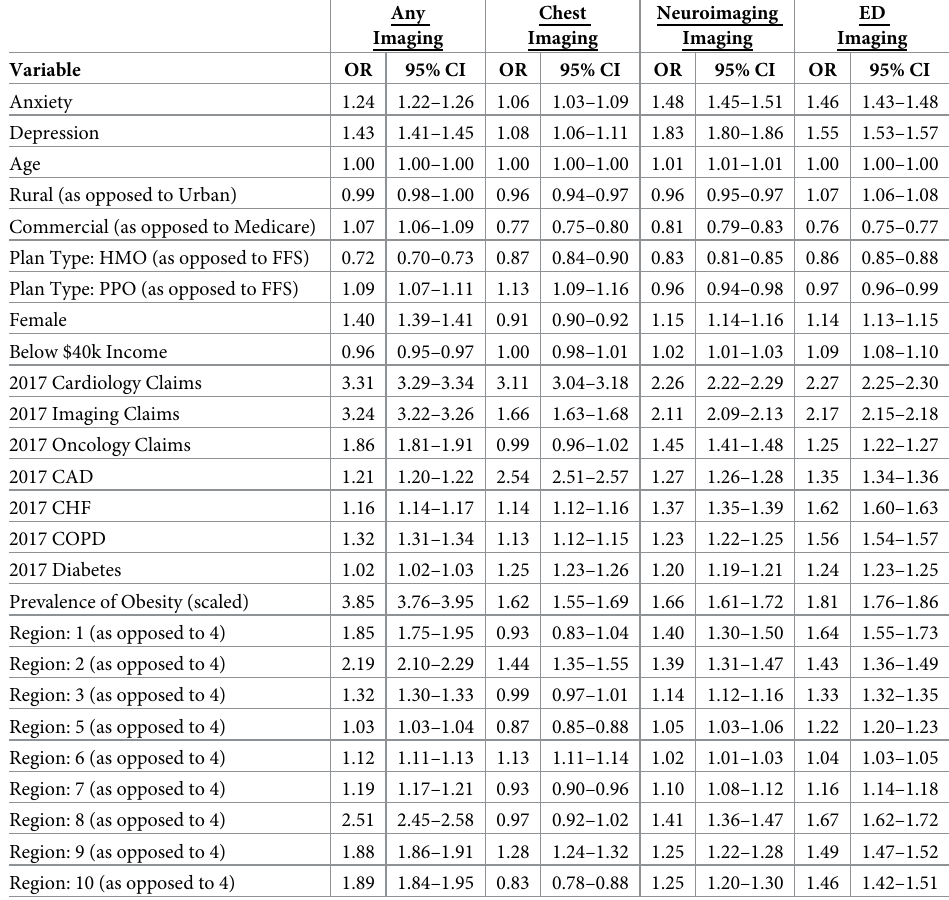
Table 2. Adjusted odds ratios for factors influencing use of any imaging (sample before